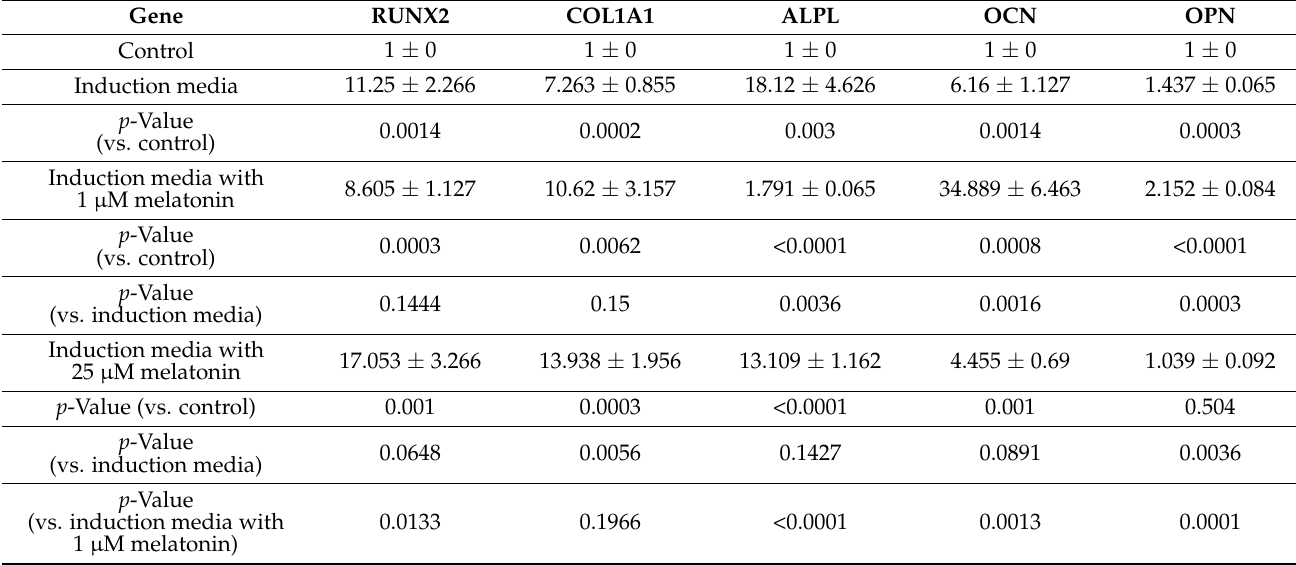
Table 6. Relative gene expression of osteogenesis ‐ related genes.